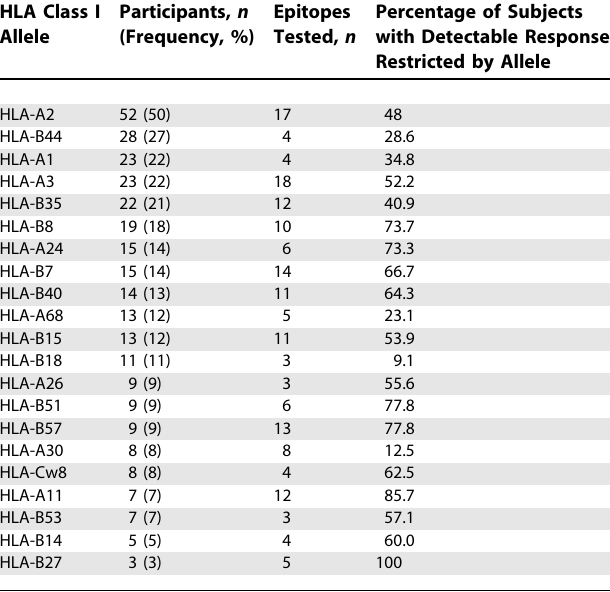
Table 1. HLA Class I Frequencies in Study Population HLA Class I Participants, n Epitopes Percentage of Subjects Allele (Frequency, %) Tested, n with Detectable